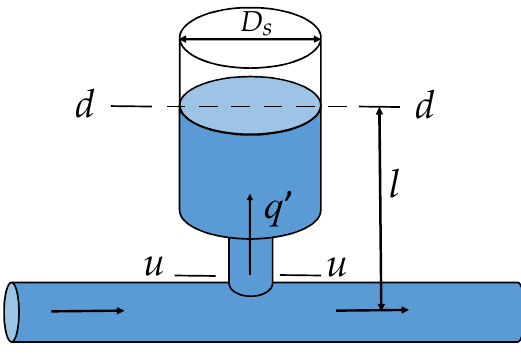
Figure 4. Sketch of the throttled surge